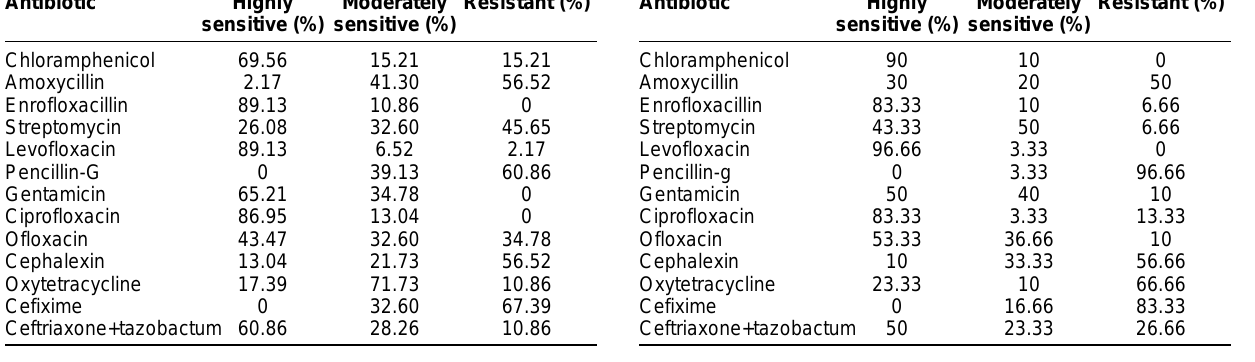
Table-4. Antibiogram of Streptococcus isolates Antibiotic Highly